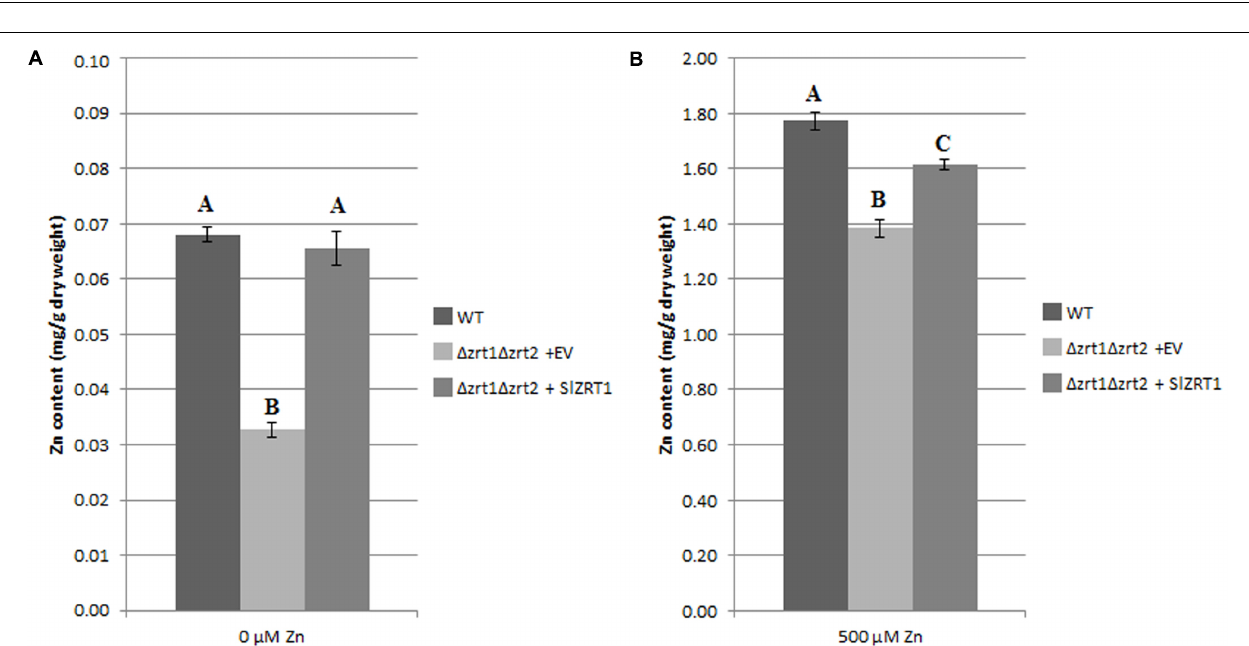
FIGURE 4 | Localization of the SlZRT1:EGFP fusion protein to the plasma membrane in yeast (a–d) . (a) Bright field image, (b) EGFP fusion protein, (c) FM4-64 plasma membrane staining, and (d) merged images. SlZRT1:EGFP and FM4-64 plasma membrane staining co-localize.